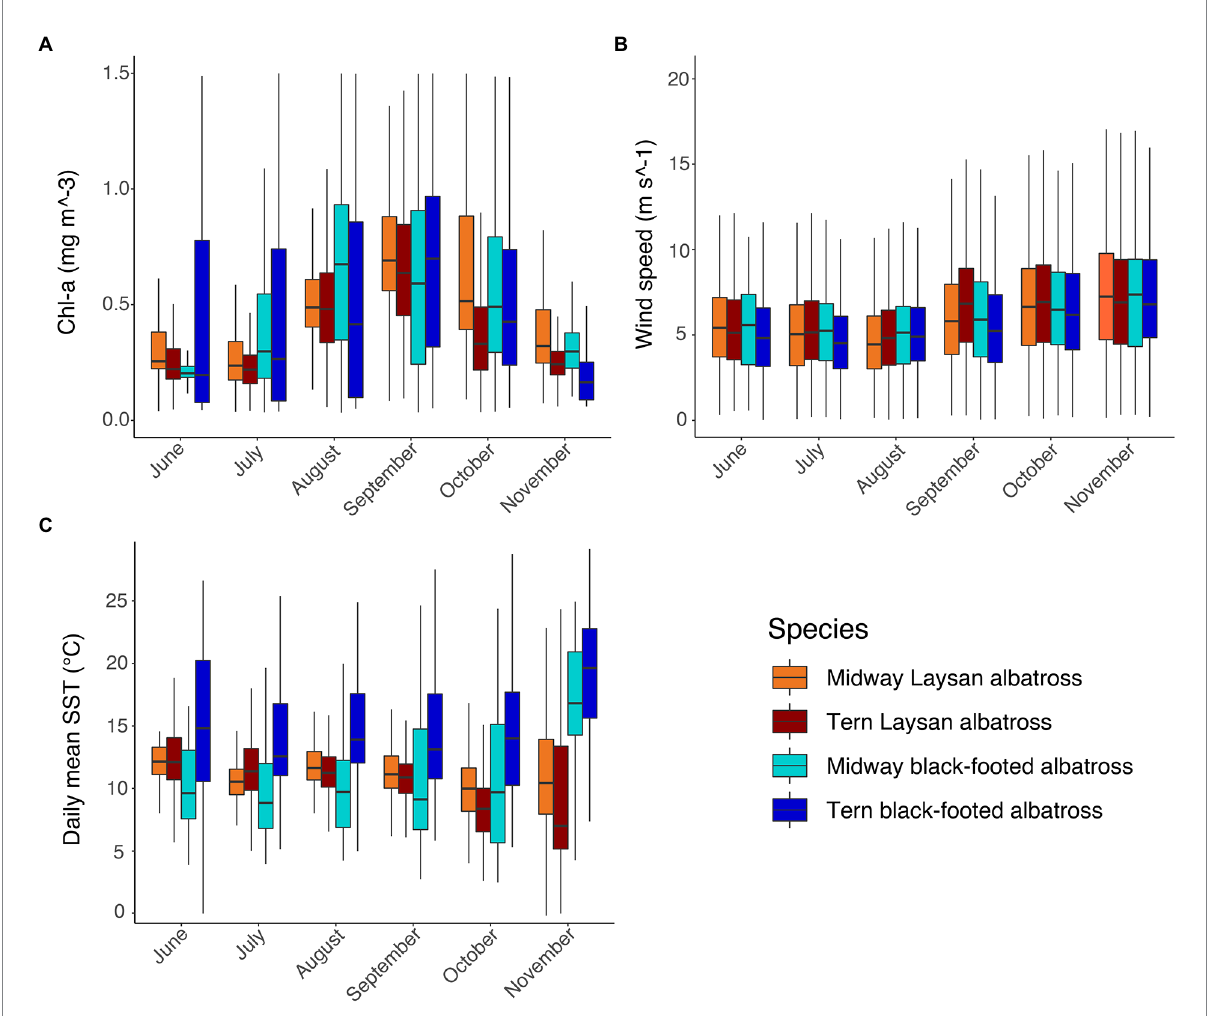
FIGURE 4 Environmental characteristics in post-breeding habitat of Laysan and black-footed albatross by month, species, and breeding colony: (A) Chlorophyll-a concentrations (mg m − 3 ), (B) wind speed (m s − 1 ), and (C) SST ( °